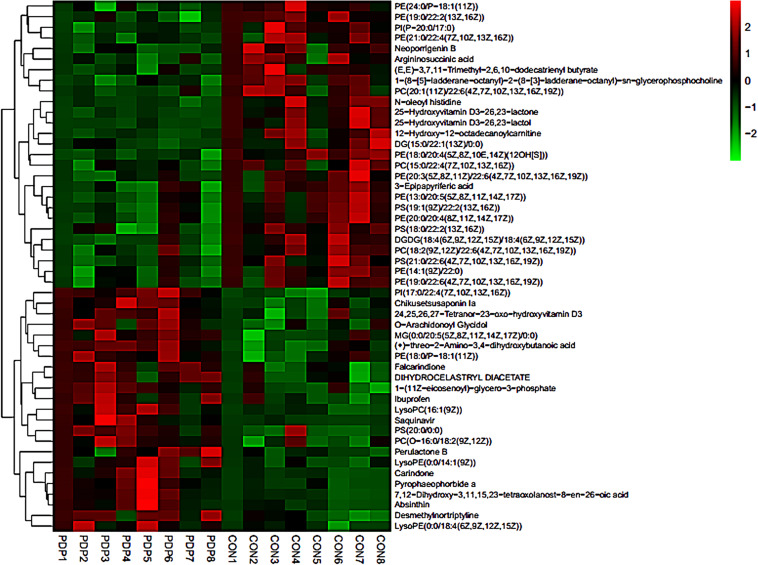
The heat maps of overall differential metabolites from the control (CON) and pedal peptide-type neuropeptide injected (PDP) groups. Each line represents a differential metabolite and each cross represents a muscle sample. Different colors represent different higher abundance intensity (mean value acquired from all detected samples of the same group).